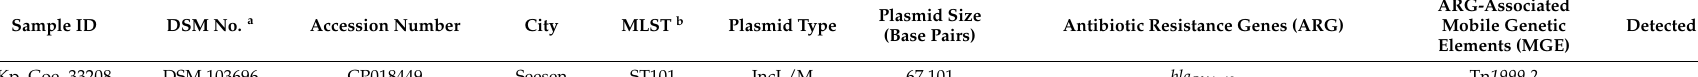
Table 3. Detected plasmids, associated antibiotic resistance genes, and detected antibiotic resistances in seven OXA-48 producing Klebsiella pneumoniae isolates. Sample